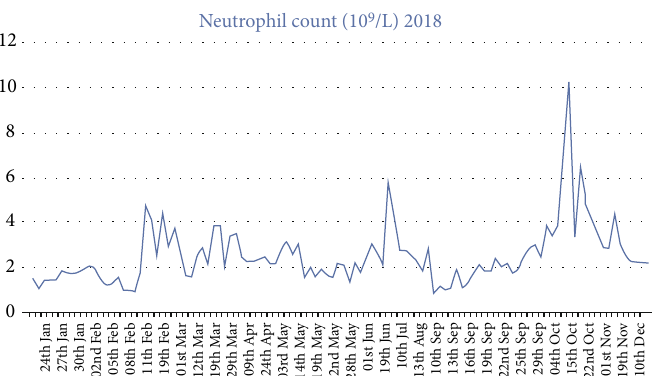
Figure 1: Neutrophil serum level from 22nd of January to 10th of December 2018. Figure 1 displays the neutrophil level by serum testing from 22nd of January to 10th of December 2018. The x axis demonstrates dates of sampling, and the y axis corresponds with absolute neutrophil count (ANC) × 10 9 /L. Initially, there is a period of neutropenia ( 1 : 0 × 10 9 /L - 2 : 0 × 10 9 /L ). Filgrastim, G-CSF 30 MU, was prescribed on February 10th resulting in an ANC which increased from 1 : 78 × 10 9 /L to 4 : 8 × 10 9 /L one day later. A further neutropenic episode occurred on March 4th with ANC 1 : 64 × 10 9 /L . Lithium was commenced on March 10th. Clozapine rechallenge in September corresponded with further deterioration in ANC measurements prompting close liaison with hematology to devise a fi lgrastim treatment protocol.